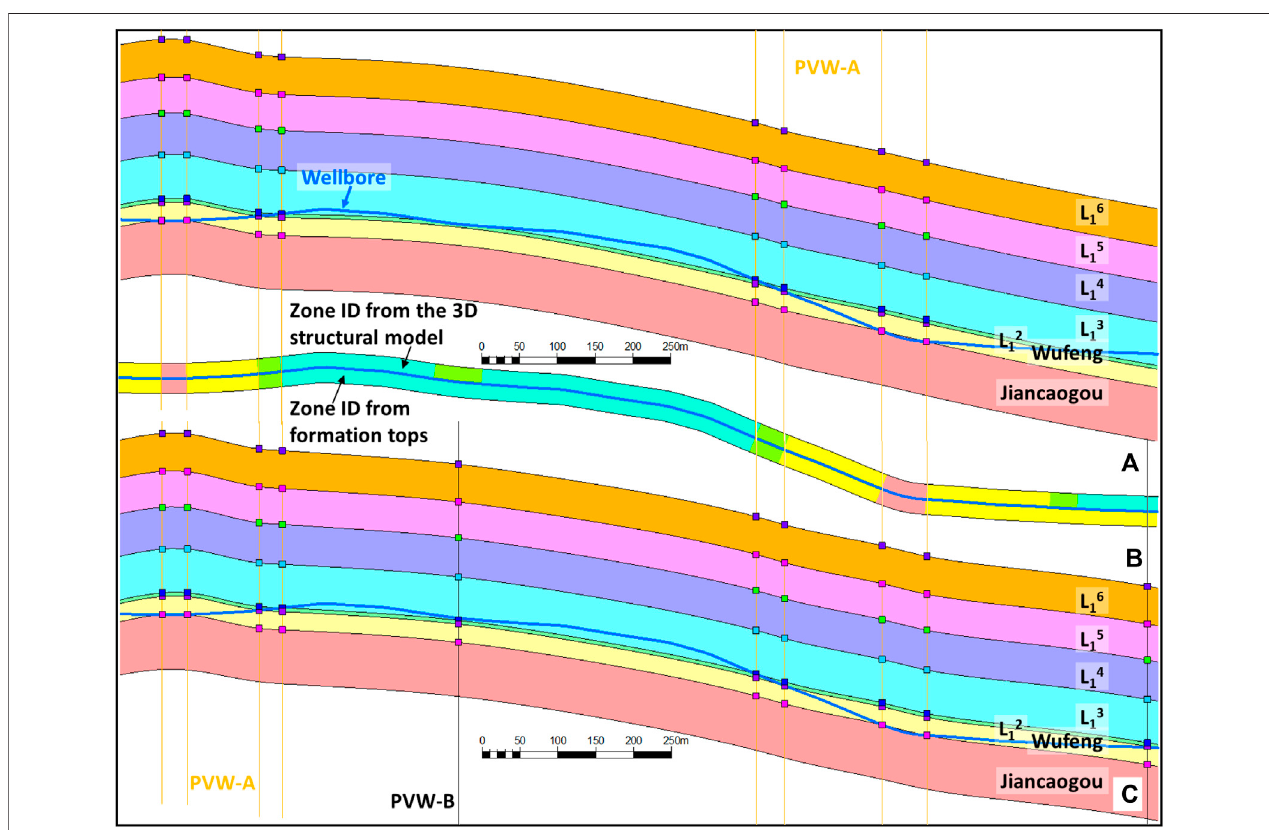
FIGURE 11 | Examples of errors in the 3D structural model (A – B) and the pseudo vertical wells added to fi x these errors (PVW-B) (C) .